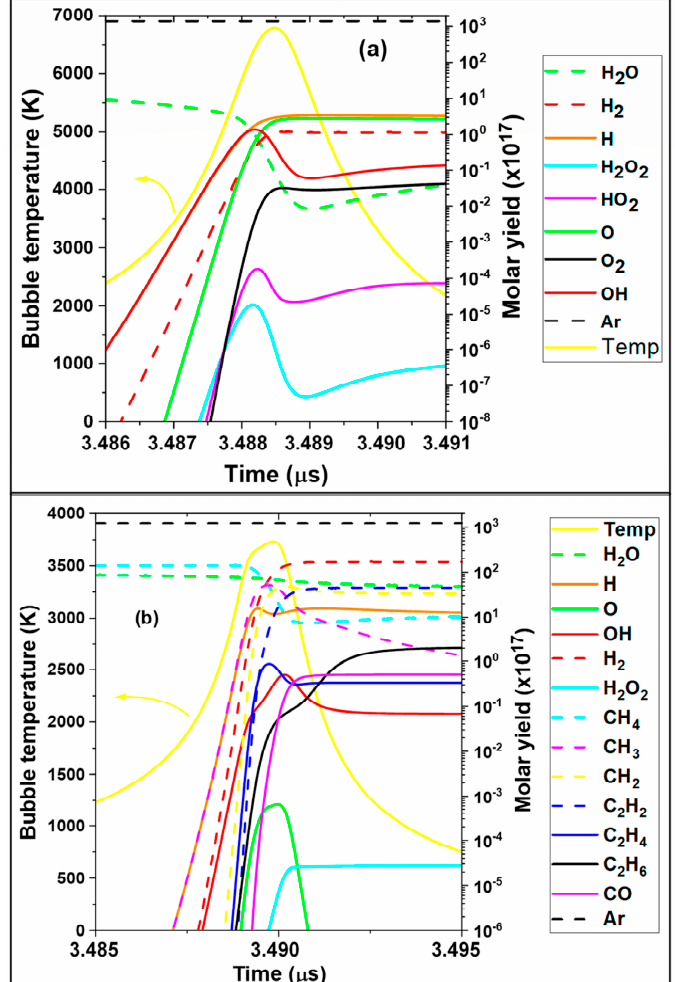
Figure 1. Bubble chemistry and temperature evolution at around the end of the bubble collapse for: ( a ) argon saturated water; and ( b ) argon–methane (X CH4 = 0.1) saturated water. Ultrasound frequency (f): 213 kHz, acoustic intensity (In): 1 W/cm², liquid temperature: 20 °C.